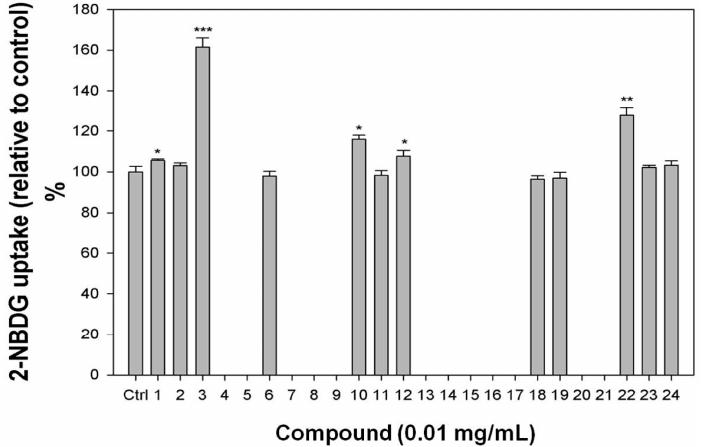
Figure 5. Glucose uptake test in differentiated 3T3-L1 adipocytes for pure compounds 1 – 24